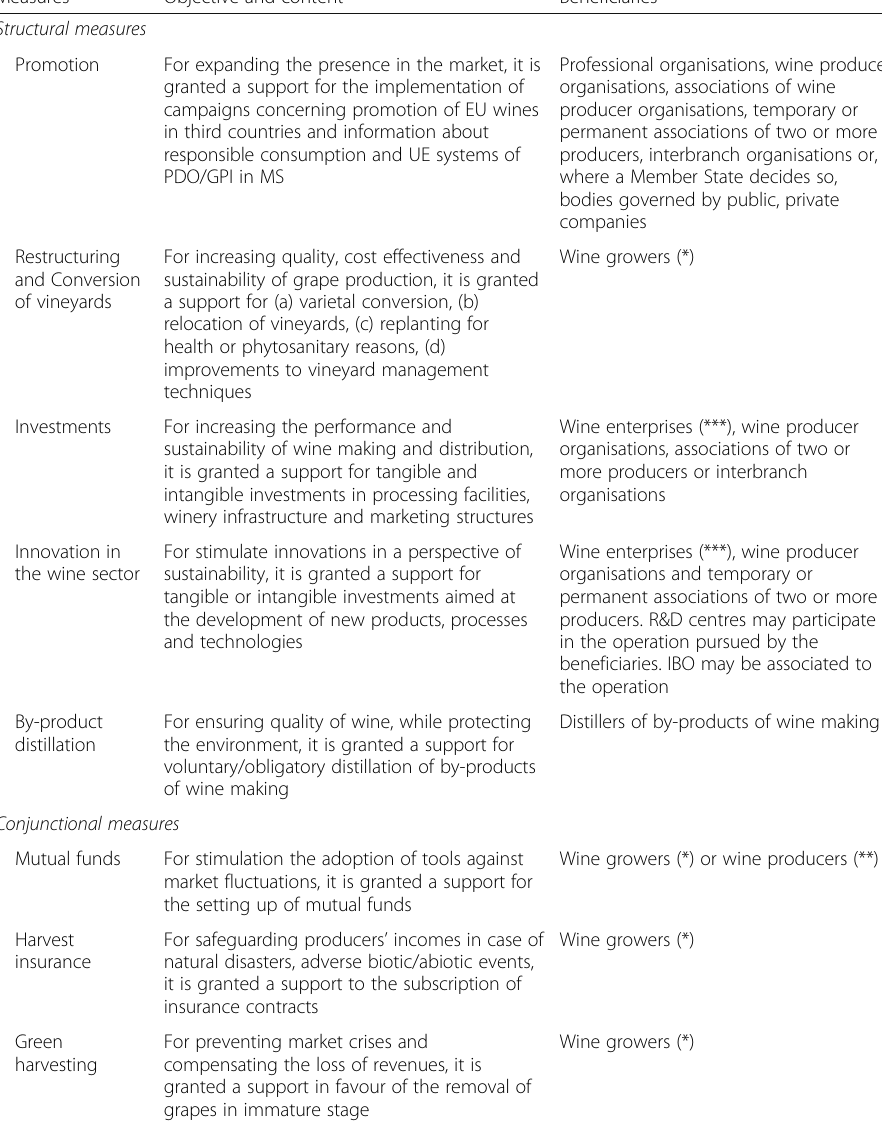
Table 3 National Support Programme measures: nature, objective, content and beneficiaries Measures Objective and